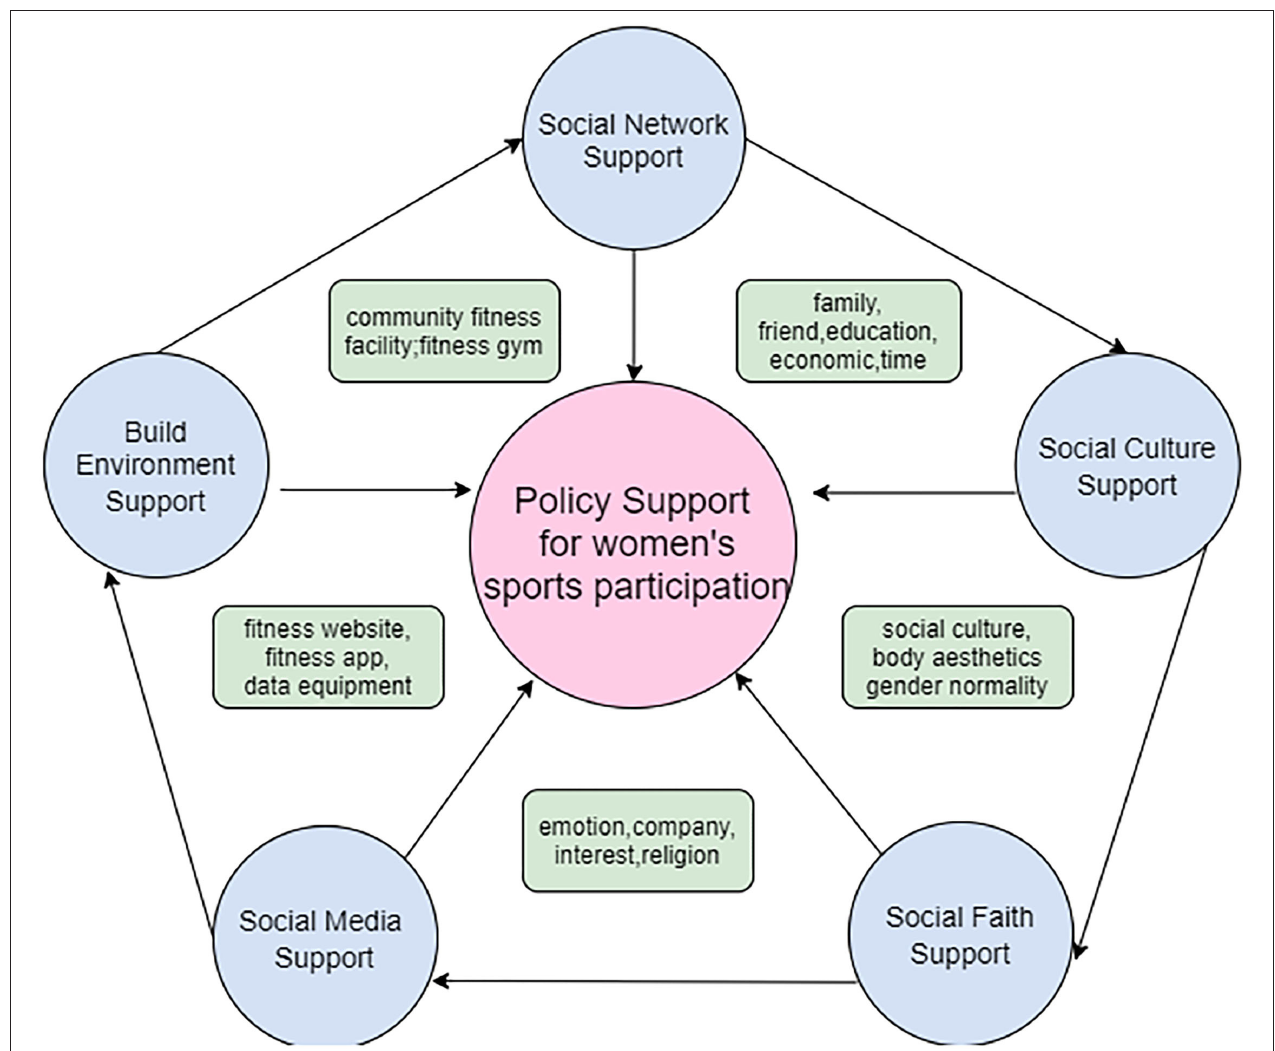
FIGURE 2 | Policy recommendations to promote Chinese female sports